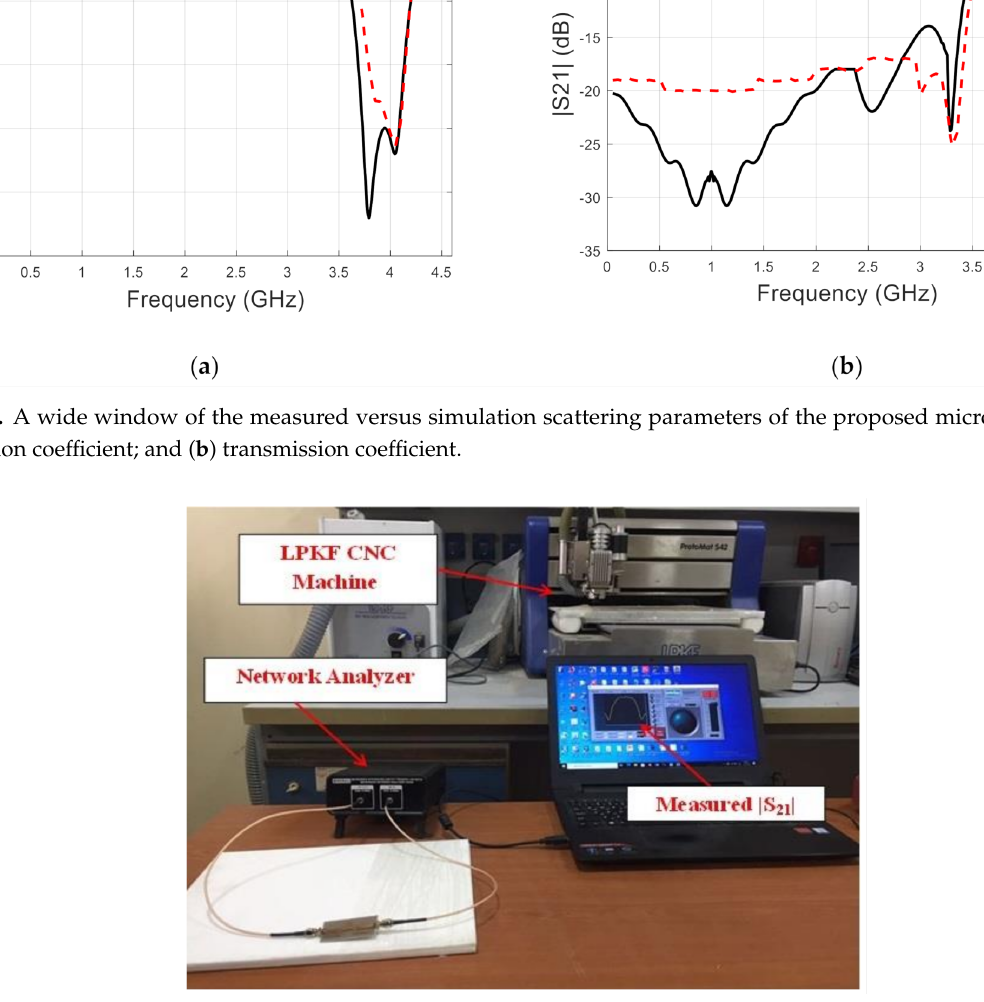
Figure 13. Photograph of the measurement setup for the proposed